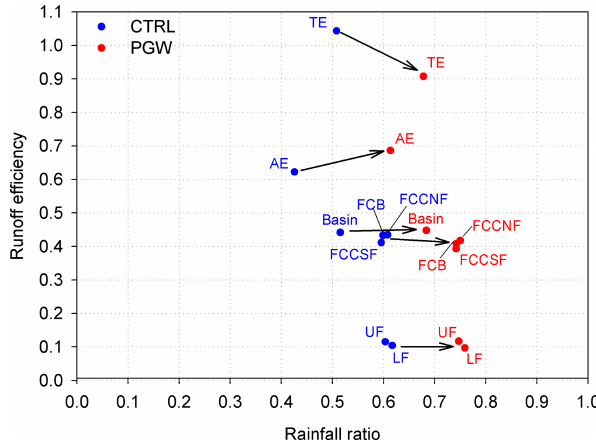
Figure 14. Mean rainfall ratio and runoff efficiency for WRF CTRL and PGW for alpine (AE), treeline (TE), upper forest (UF), forest clearing blocks (FCB), forest circular clearing north-facing (FC- CNF), forest circular clearing south-facing (FCCSF), and lower for- est (LF) ecozones and the entire Marmot Creek